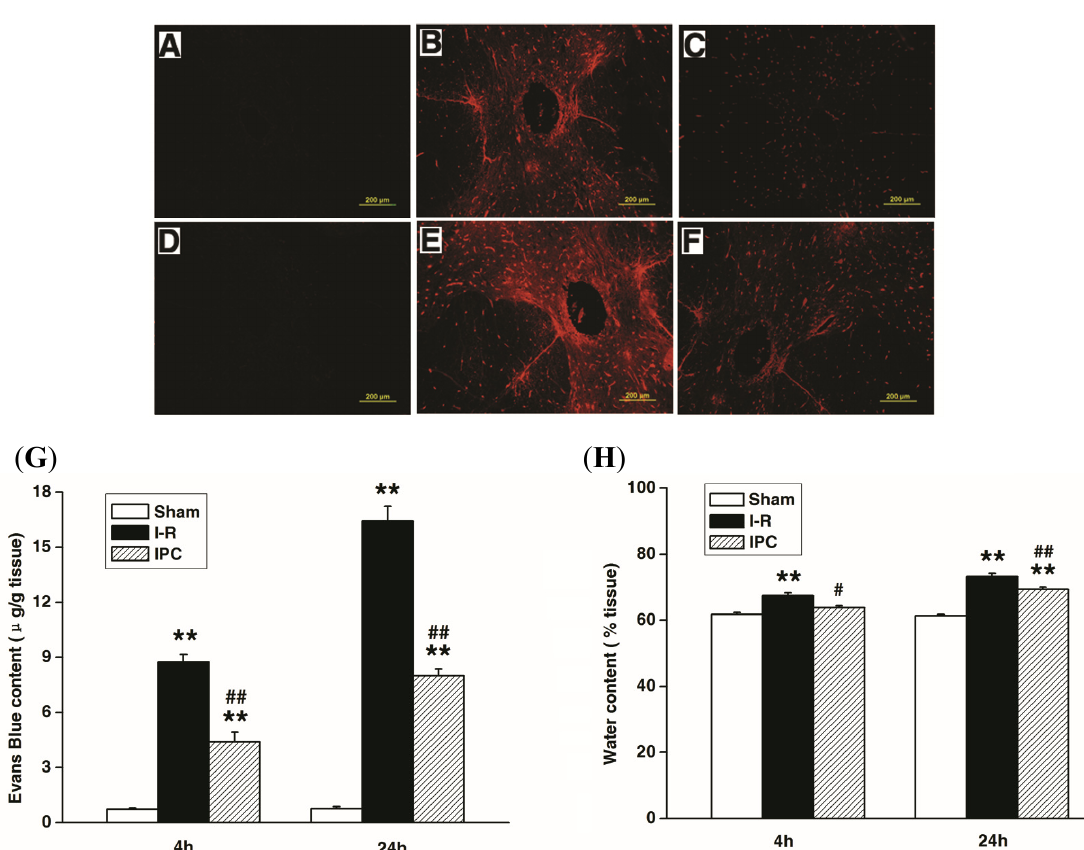
Figure 2. IPC inhibited the blood spinal cord barrier breakdown after spinal cord ischemia-reperfusion (I-R) injury. Blood spinal cord barrier permeability was measured at 4 and 24 h after injury using Evan’s Blue dye, and spinal cord edema was measured at 4 and 24 h by tissue water content. ( A – F ) Representative fluorescence images of Evan’s Blue extravasation in spinal cord parenchyma across groups: ( A ) Sham 4 h; ( B ) I-R 4 h; ( C ) IPC 4 h; ( D ) Sham 24 h; ( E ) I-R 24 h; ( F ) IPC 24 h; ( G ) Quantification of the content of Evan’s Blue in the injured spinal cord; ( H ) Quantification of the water content of the spinal cord. All data represent mean ± SEM ( n = 6/group). ** p < 0.01 versus Sham group. # p < 0.05, ## p < 0.01 versus I-R